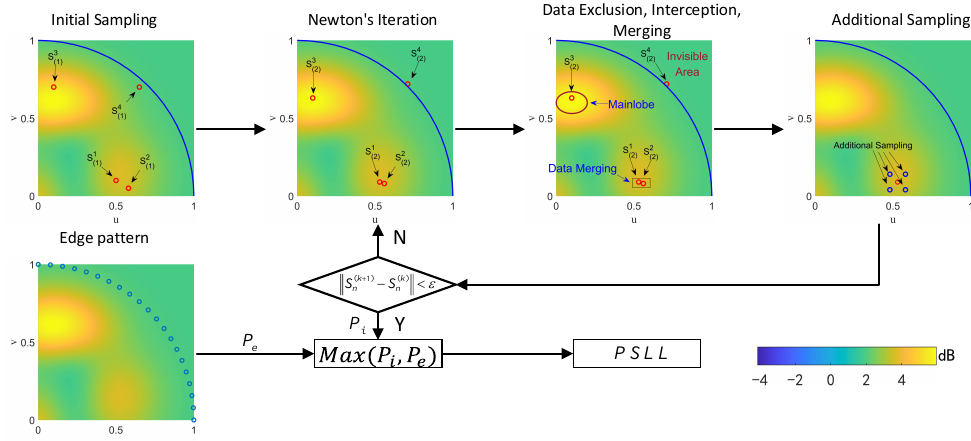
Figure 2. The procedure of peak sidelobe seeking (S m